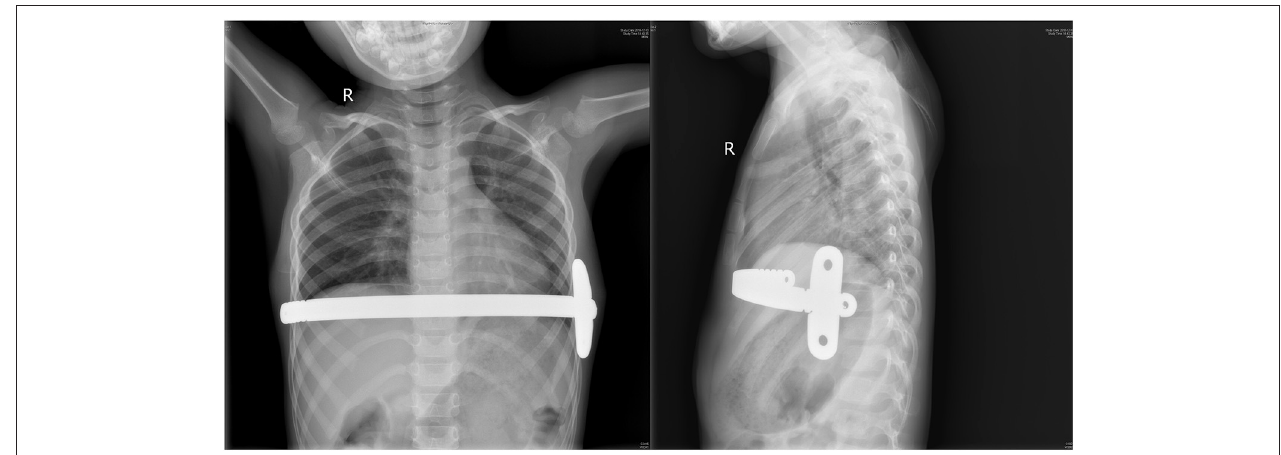
FIGURE 3 | The chest radiograph showed that bar placement and fixation 3 days after surgery.